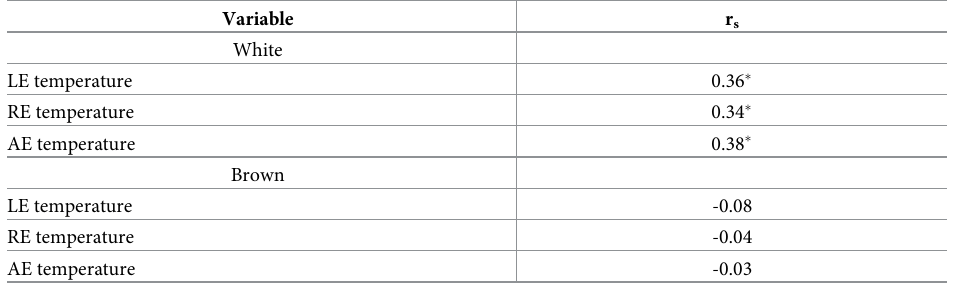
Table 6. The Spearman rank correlation coefficients between the time of tonic immobility and surface tempera- ture after tonic immobility for White Leghorn and Hy-Line brown line (n = 141).